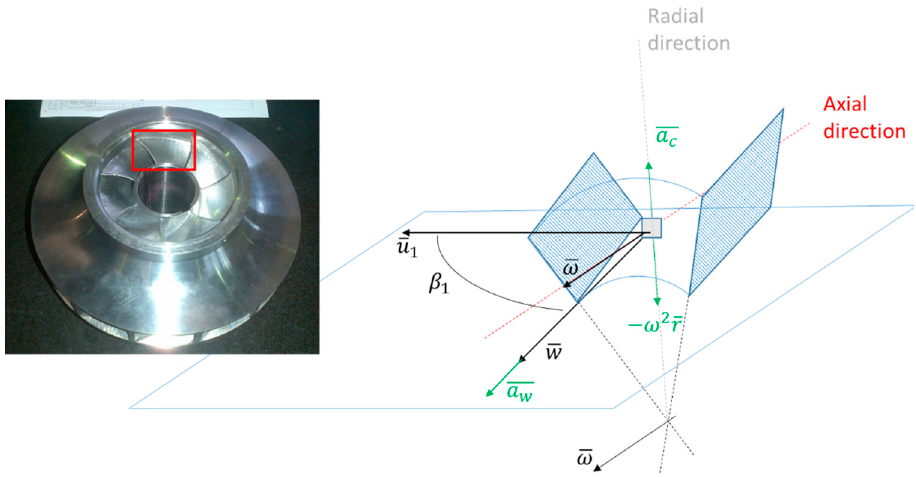
Figure 2. Representation of the main velocity vectors and accelerations referred to the particle of fluid at the outlet of the runner. The vector magnitudes are drawn qualitatively.